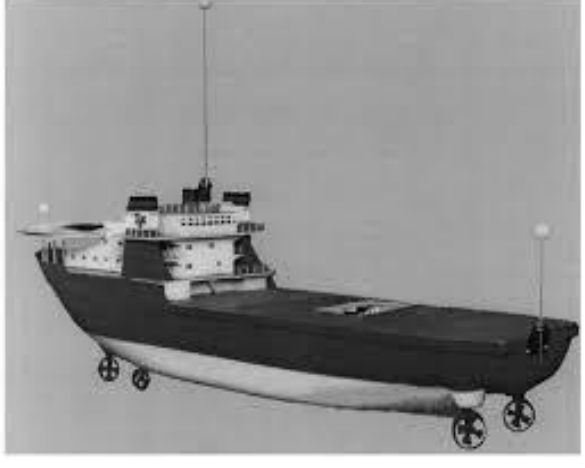
Fig. 3. Cyber-Ship-I